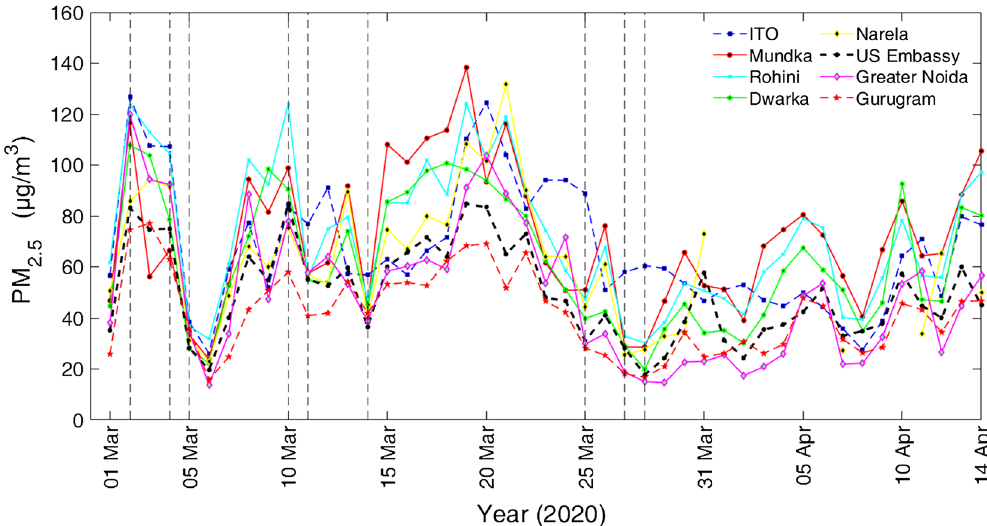
Figure 2. Daily averaged PM 2.5 concentration from 1 March to 14 April 2020 (covering first phase of lockdown period from 25 March to 14 April) over eight stations (ITO, Mundka, Rohini, Dwarka, Narela, US Embassy, Greater Noida and Gurugram). In addition, rainfall occurrence days are shown with vertical dashed lines, which correspond to dip in the PM 2.5 . Rainfall was relatively larger on 4–5 March 2020 (~ 15–20 mm) and 14 March 2020 (~ 40 mm) in comparison to other